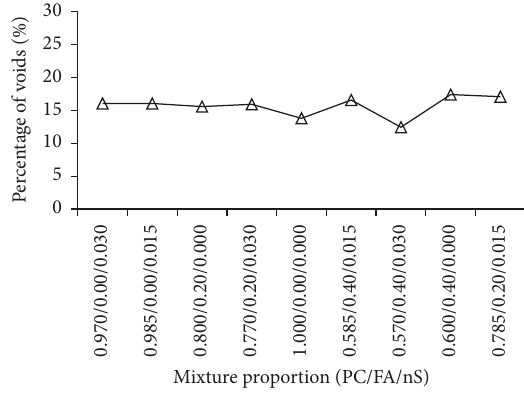
Figure 3: Mean percent of voids measured at aging day